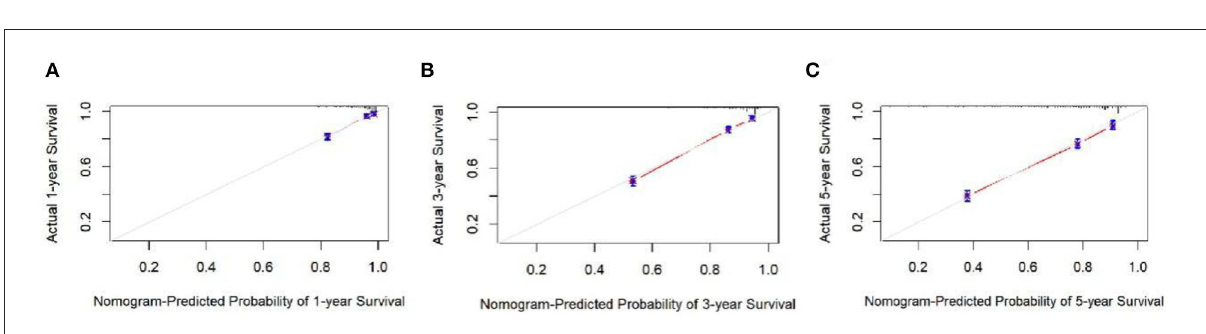
FIGURE3 Calibration curves at 1, 3, and 5 years in the modeling set. (A–C) Are the calibration curves of modeling sets 1, 3, and 5.